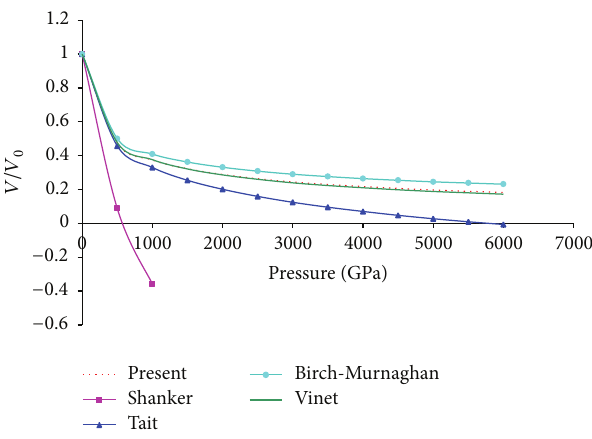
Figure 2: Compression behavior at ultrahigh pressure using differ- ent